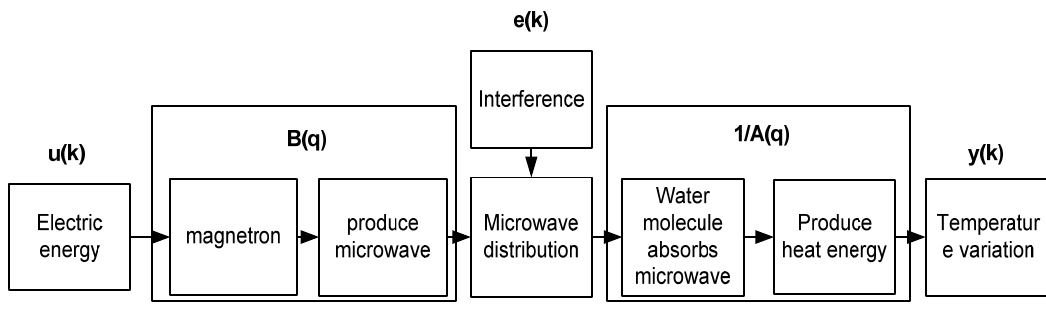
Figure 11. Relation between microwave energy transmission and system